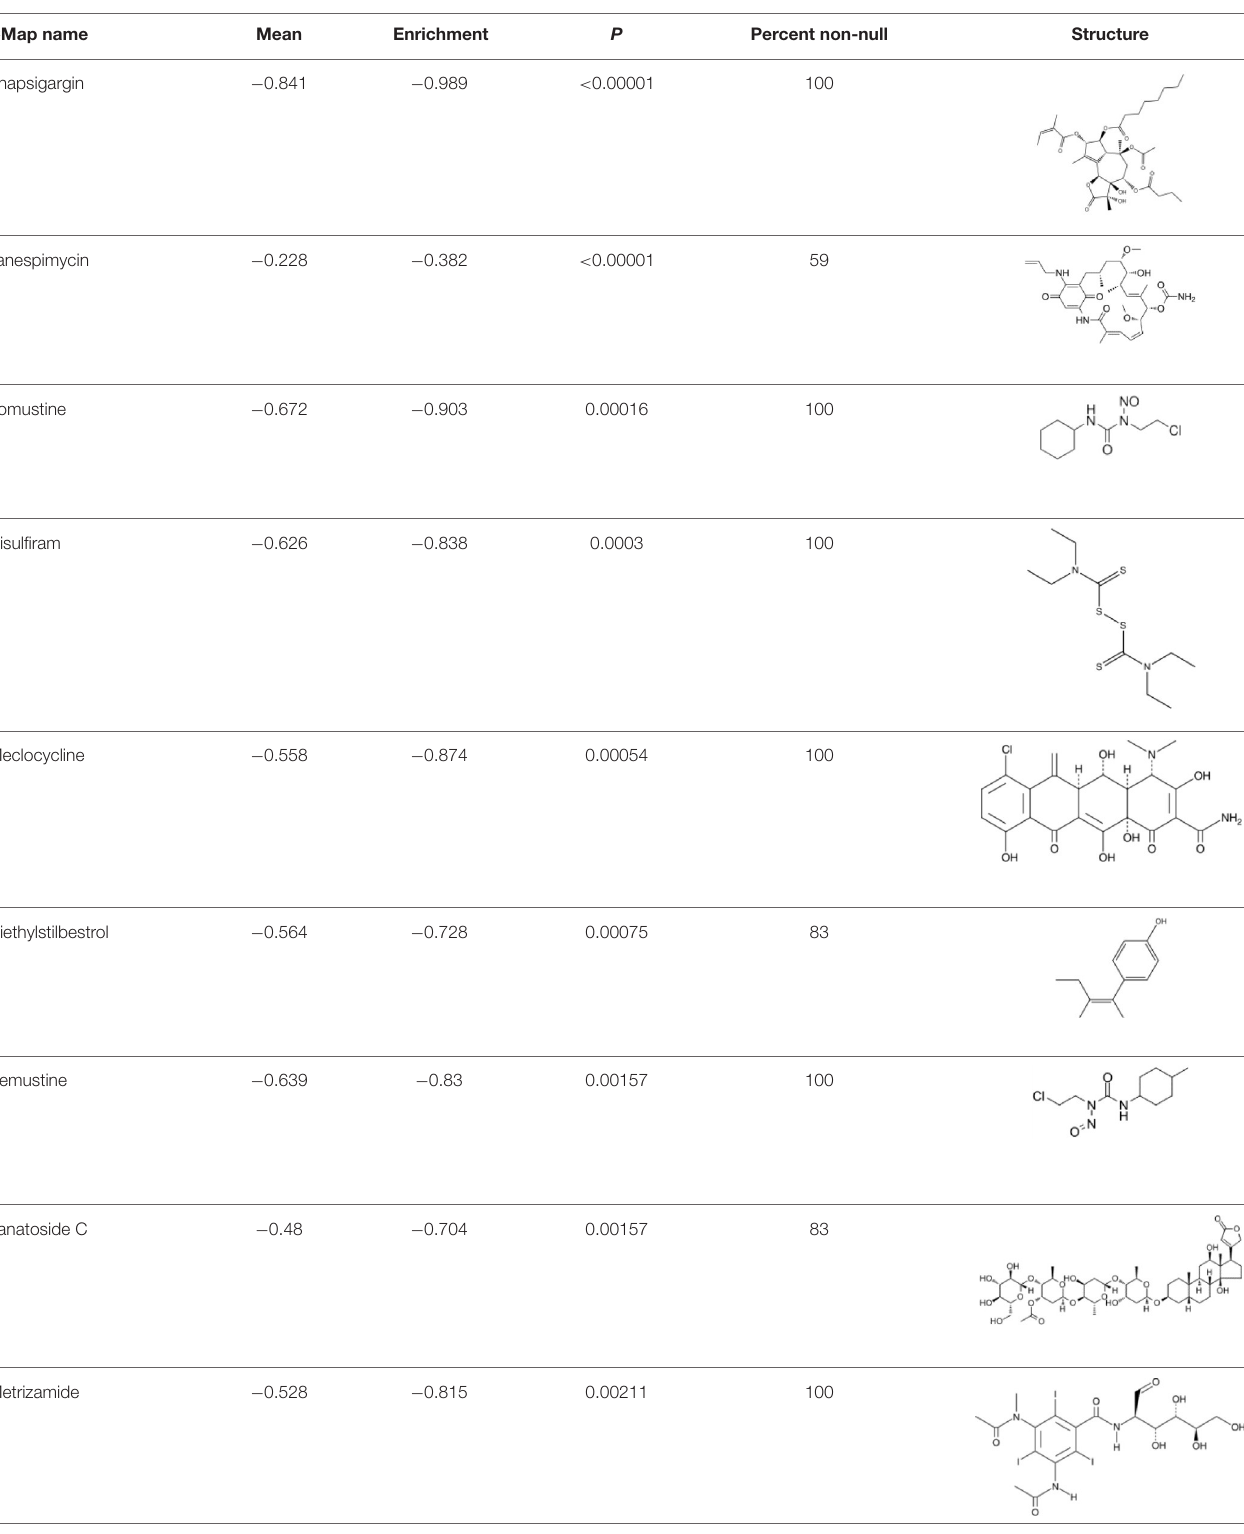
TABLE 3 | List of the 20 most significant small molecular compounds provided by connectivity map (CMap) analysis to reverse altered expression of differentially expressed genes (DEGs) in cell